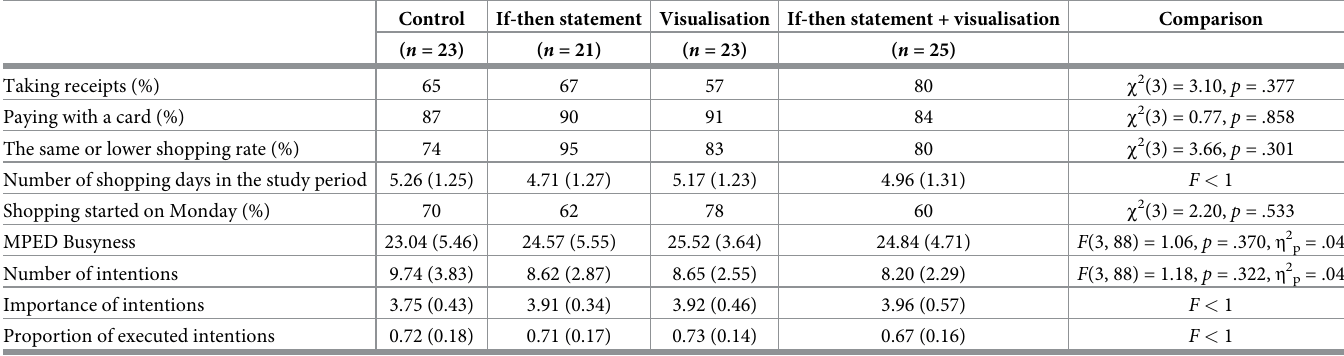
Table 2. Shopping habits and busyness measures as a function of